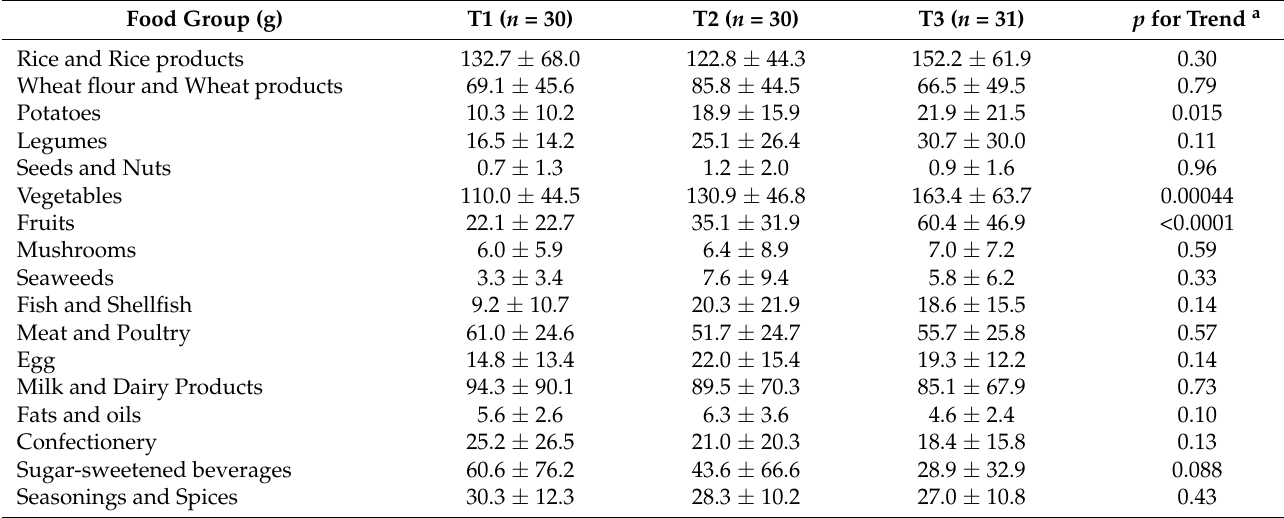
Table 4. Sensitivity analysis for food group intake across the tertile (T) categories of Nutrient-Rich Food Index 9.3 (NRF9.3) score after excluding the participants with misreported energy intake.